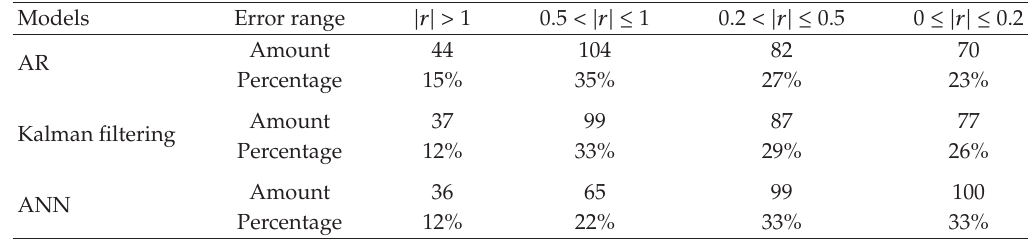
Table 4: Error distribution of forecasted